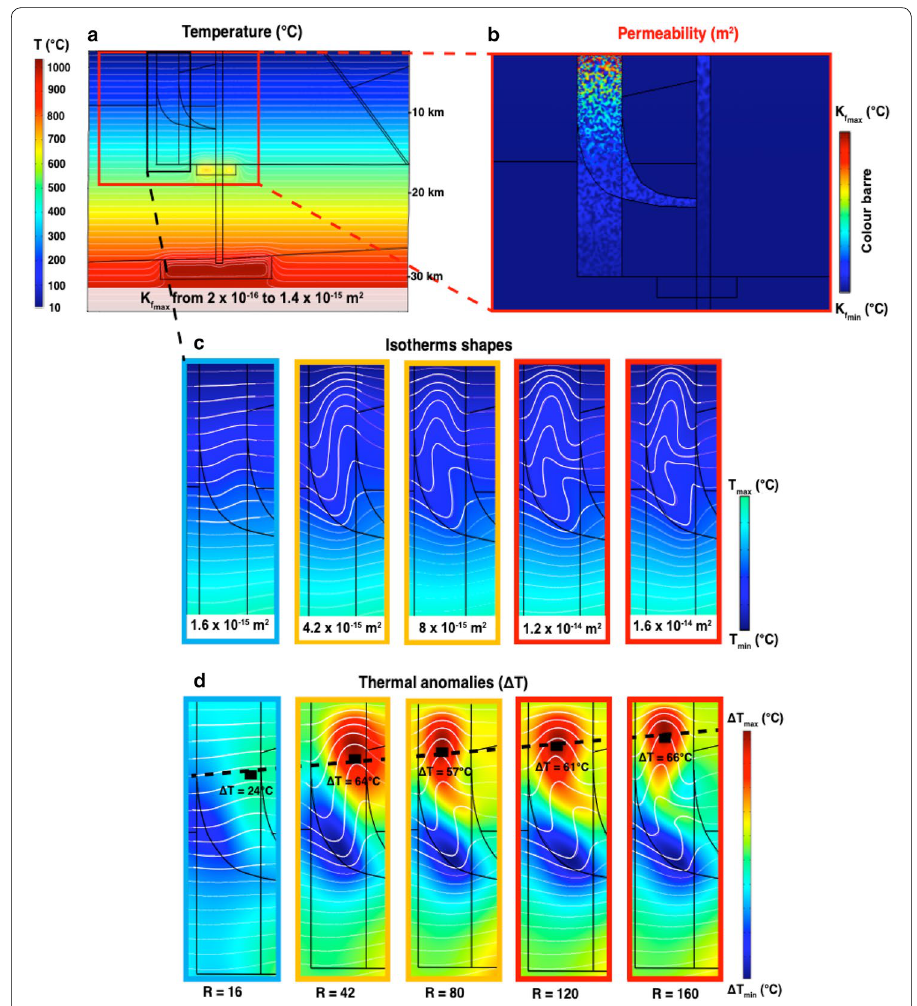
Fig. 13 Maps of temperatures ( a ), permeabilities ( b ), isotherms ( c ), and thermal anomalies ( d ) of the Pontgibaud region (at time t 0 15,000 years). In accordance with Fig. 11, color of boxes contours correspond + to one convective regime: blues boxes correspond to areas of unicellular weak‑type convection zone, oranges boxes correspond to unicellular medium‑type convection zone, and reds boxes correspond to bicellular strong‑type convection